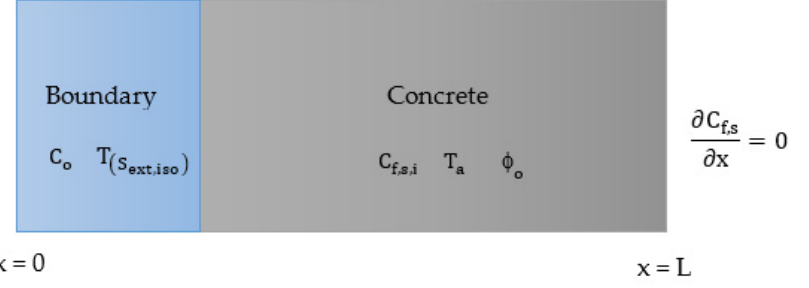
Figure 1. Geometry and boundary conditions for the problem of water-saturated concrete. Nomen- clature: C f,s is the free chloride concentration in the solution (kg/m 3 solution), C f,s,i is the initial free chloride concentration in the solution (kg/m 3 solution), C o is the free chloride concentration at the surrounding liquid (kg/m 3 solution), L is the concrete structure length (m), T a is the initial tempera- ture (° C ), T (cid:3435)(cid:2903) is the external temperature (° C ), x is the position (m) and ϕ o is the initial porosity (m 3 of pores/m 3 of concrete).